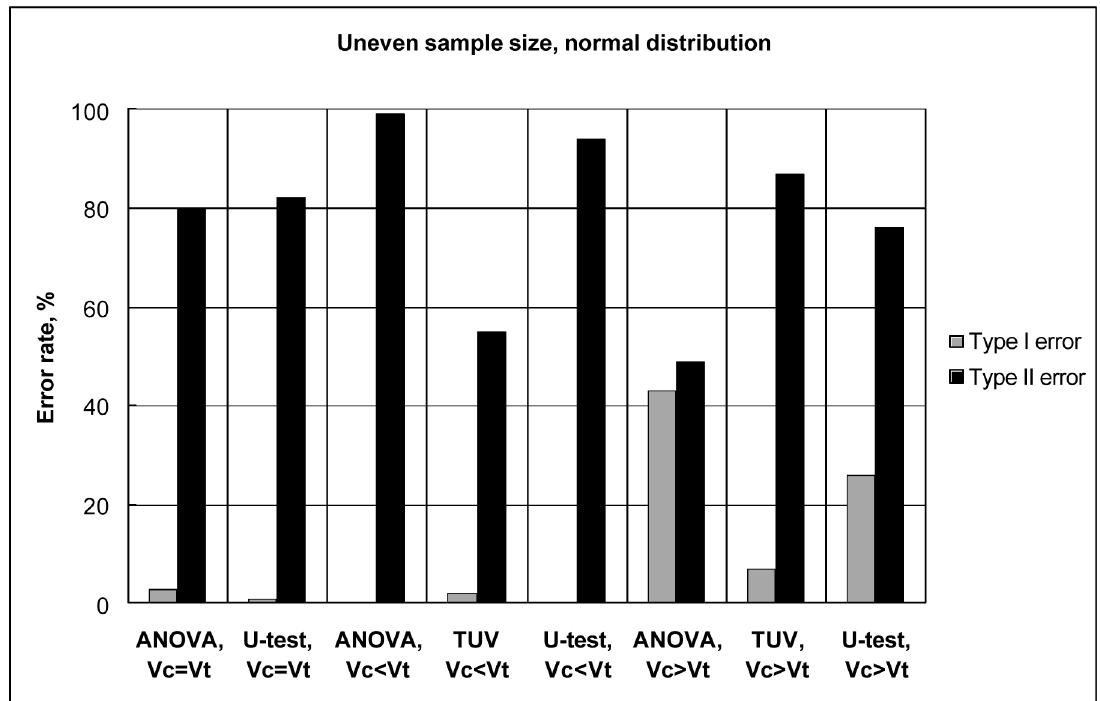
and treatment groups